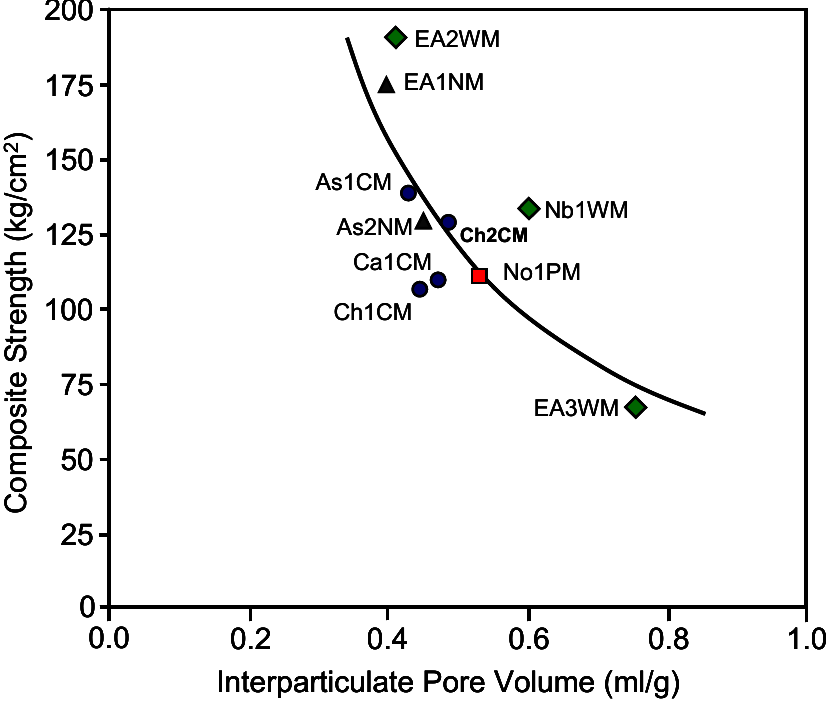
Figure 7. Relationship between the mechanical strength and interparticulate pore volume of the monolith composites. Origin of the commercial activated carbon used in the composite: coal ( ), nutshell ( ), wood ( ) and peat ( ). From reference [33], with permission from